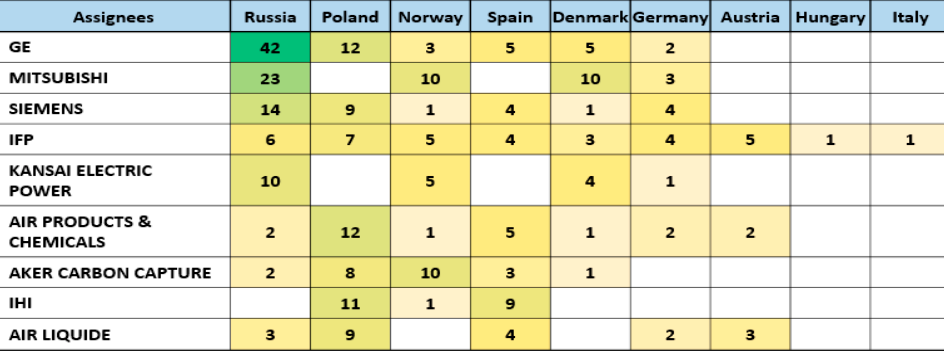
Figure 5. Patent publication countries with assignees (Industry). Color intensity is proportionate to higher figure i.e., the more green it is the higher the number of assignees in each country it repre- sents.